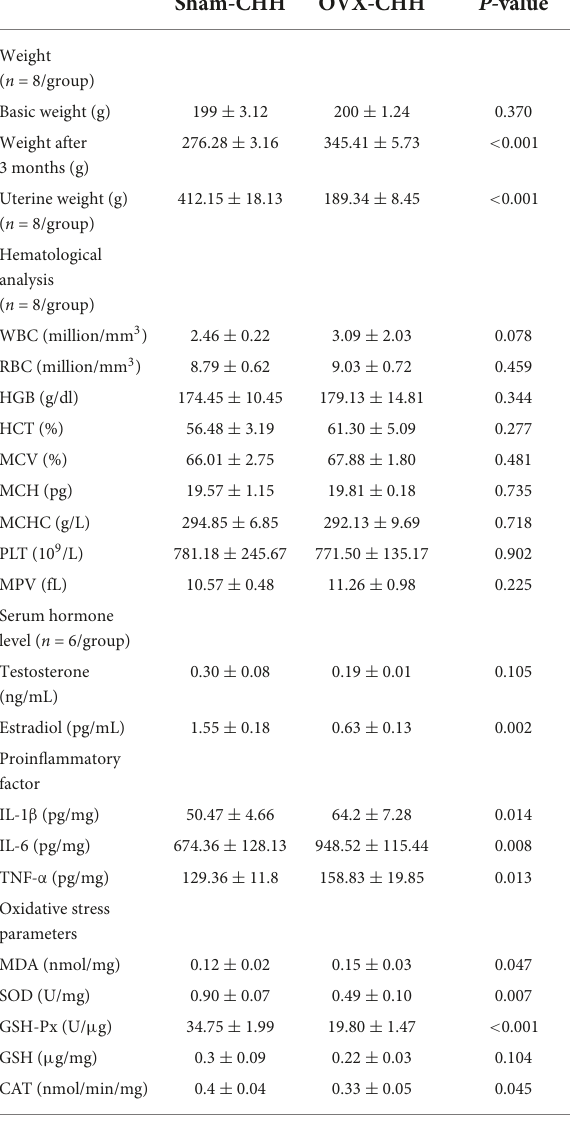
TABLE 6 Effects of OVX on body weight, serum sex hormones, hippocampal inflammatory factors, and oxidative stress parameters in female rats exposed to